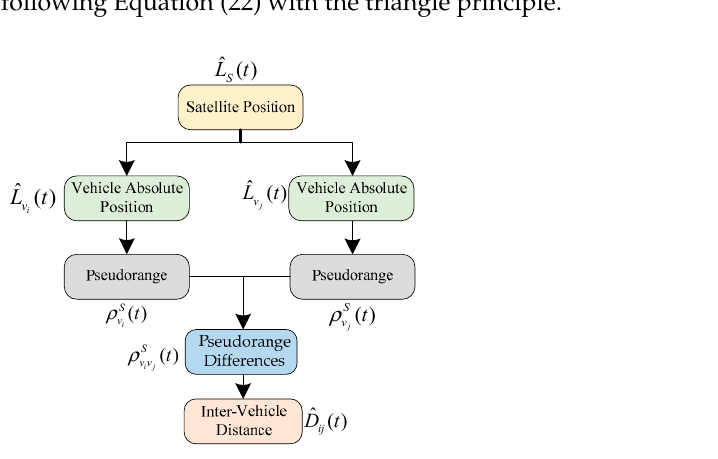
Figure 6. Flowchart of Single Differencing (SD)-based IVD estimation method.